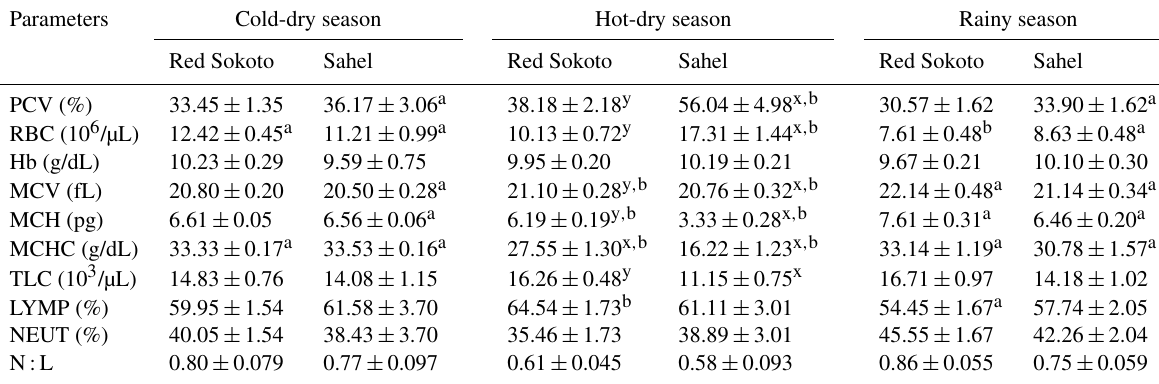
Table 4. Overall effect of season on haematological parameters of male and female Red Sokoto and Sahel goat kids.